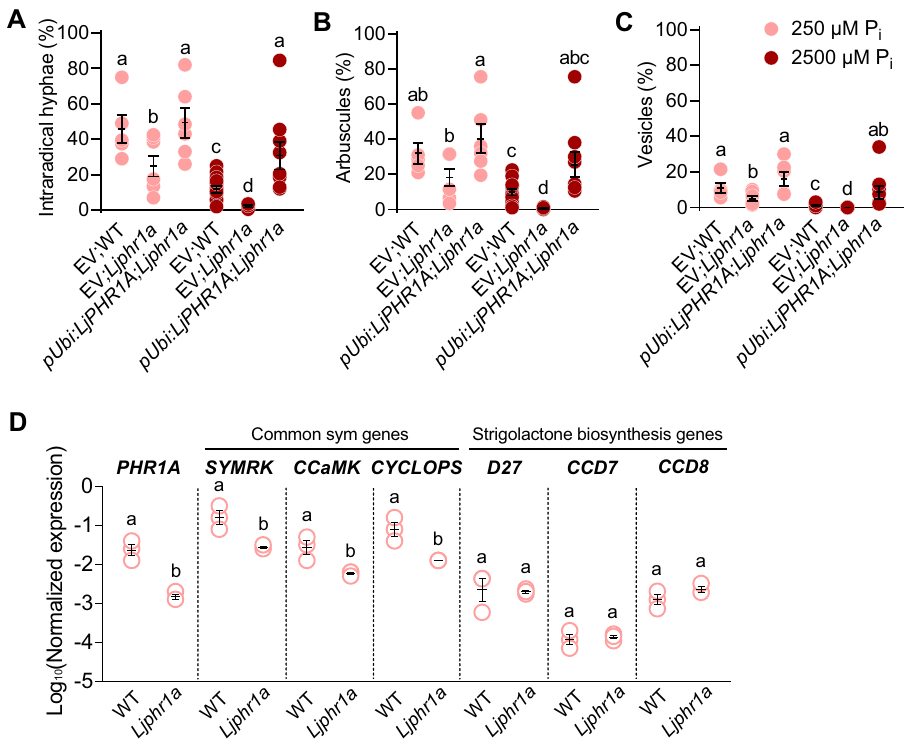
Fig. 4 PHR1A is required for full colonization of Lotus japonicus roots by R. irregularis . Percent intraradical hyphae ( A ), arbuscules ( B ), and vesicles ( C ) of hairy roots for indicated genotypes inoculated with R. irregularis (AMF) for 4 weeks at 250 µ M P i or 2500 µ M P i . EV, empty vector. D Relative transcript accumulation in mock-inoculated (Mock) hairy roots of the indicated genotypes in parallel with the experiment in Fig. 5A – C. Statistics: Individual data points and mean ± SE are shown. A – C N = 5 – 13 independent plants; Brown – Forsythe and Welch ’ s One-Way ANOVA test with Games – Howell ’ s multiple comparisons test. Different letters indicate statistical differences between the samples. D N = 3 independent root systems; Mann – Whitney test (two- tailed). Different letters indicate statistical differences between statistical groups.